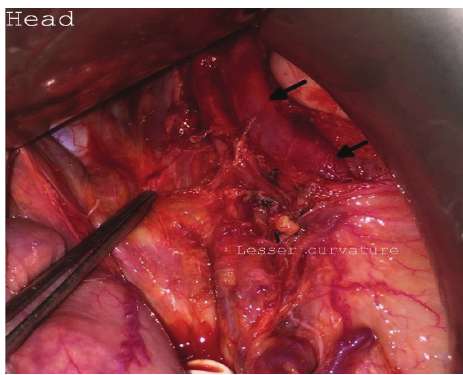
Figure 2. Intraoperative photograph showing bulging mucosa (arrow) of the esophagus following adequate myotomy.